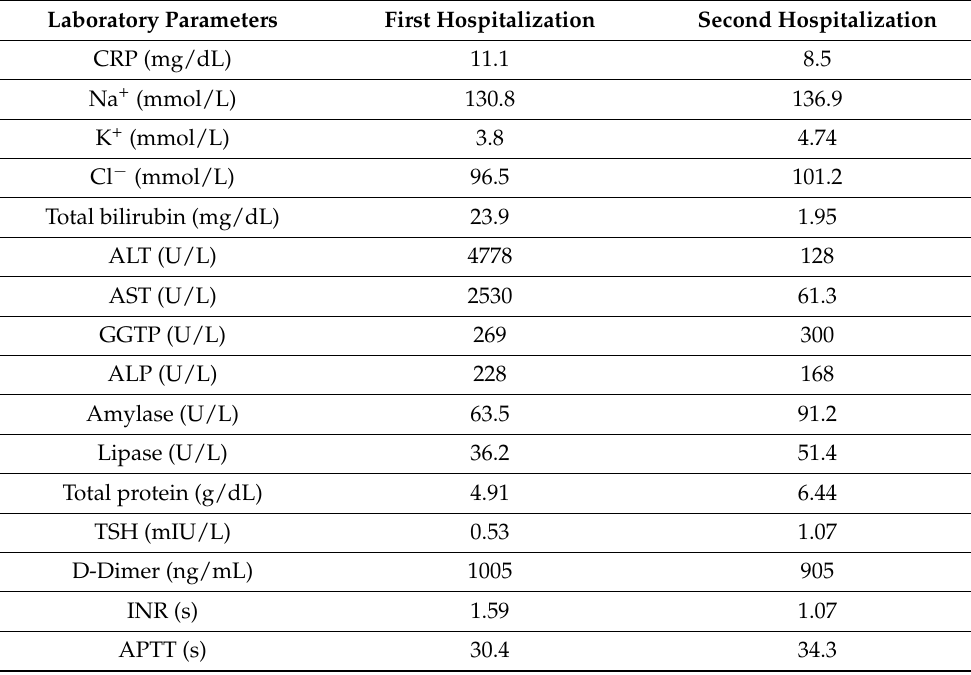
Table 2. The laboratory tests’ results during both hospitalizations.